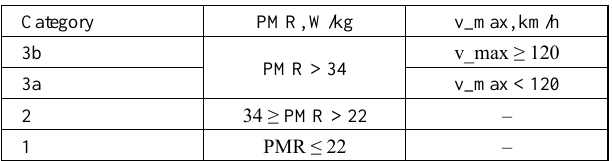
Table 2. WLTC test cycle categories with corresponding PMR coefficients and maximum speed values [1]